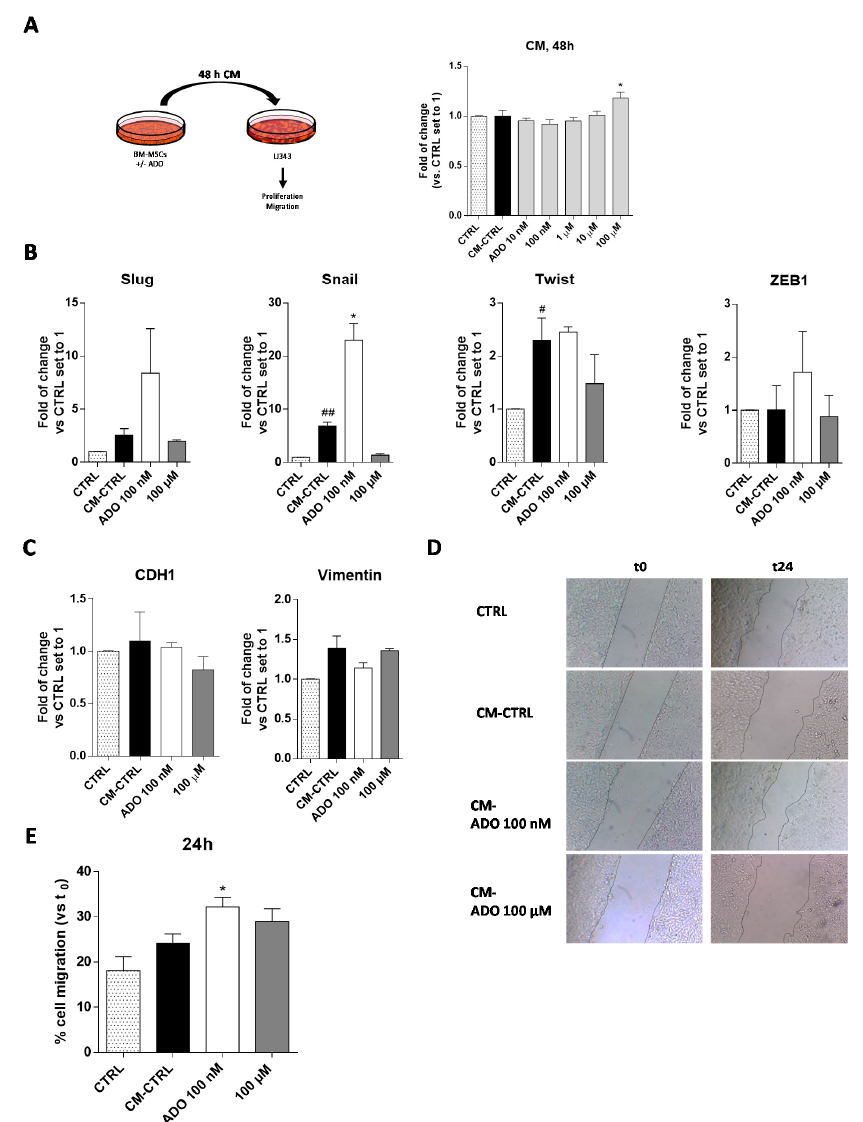
Figure 5. ADO modified the BM-MSC secretome affecting the U343MG proliferation, GMT traits and cell motility. ( A ) U343MG cells were grown in 80% U343MG culture medium + 20% BM-MSC medium (CTRL), CM obtained from untreated cells (CM-CTRL) or cells treated with ADO for 48 h. At the end of the treatments, cell proliferation was evaluated using the MTS assay. The data are expressed as the percentage versus the CTRL, which was set to 100%, and they are presented as the mean values ± SEM of three independent experiments, each performed in duplicate. ( B , C ) U343MG cells were treated as described above and, after 72 h of treatment, mRNA expression levels of Slug, Snail, Twist, ZEB1, CDH1 and Vimentin were determined by RT-PCR. The data are expressed as fold changes with respect to untreated cells set to 1 and are the mean values ± SEM of two independent experiments. ( D , E ) U343MG cells were treated as above, and representative images ( D ) of the scratch wounds at 0 and 24 h after treatment are reported. ( E ) The data are expressed as percentage of gap closure after 24 h of treatment compared to the CTRL set to 100%. The data are represented as the means ± SEM of at least two independent experiments performed in triplicate. The significance of the differences was determined by one-way ANOVA, followed by Bonferroni’s post-hoc test: # p < 0.05, ## p < 0.01 vs. CTRL; * p < 0.05 vs. CM-CTRL.